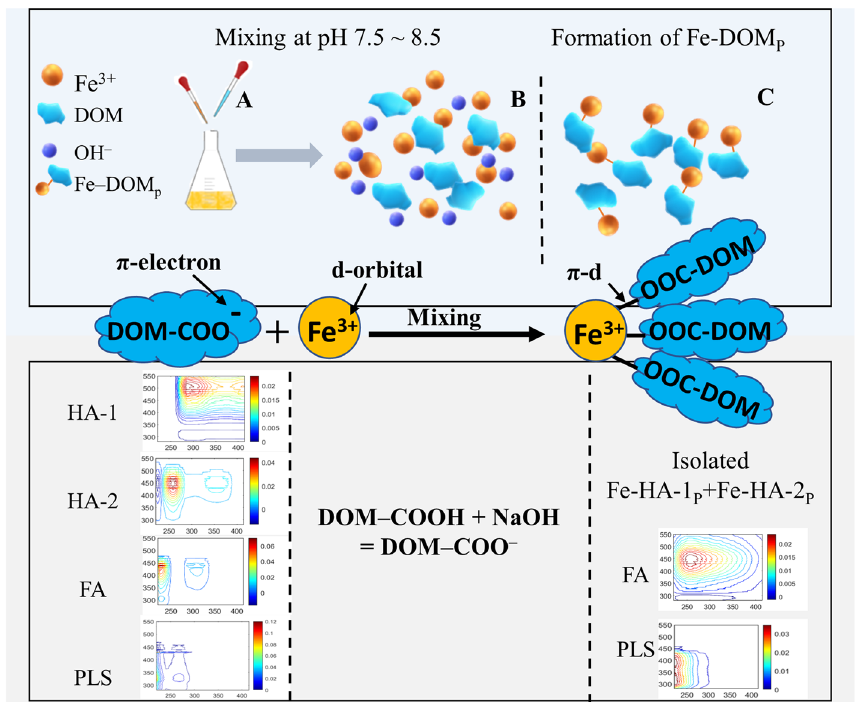
Figure 5. Conceptual model of the formation of Fe ‒ dissolved organic matter (DOM) precipitates (Fe ‒ DOM P ) after subsequent additions of aqueous solutions of FeCl 3 at pH 7.5 ‒ 8.5. ( A ) FeCl 3 was slowly added to the pH adjusted /7.5 ~ 8.5) DOM solutions with simultaneous addition of NaOH to keep the pH at 7.5–8.5, under gentle magnetic stirring; ( B ) the reaction system was mixed and allowed to react at pH 7.5 ~ 8.5; ( C )